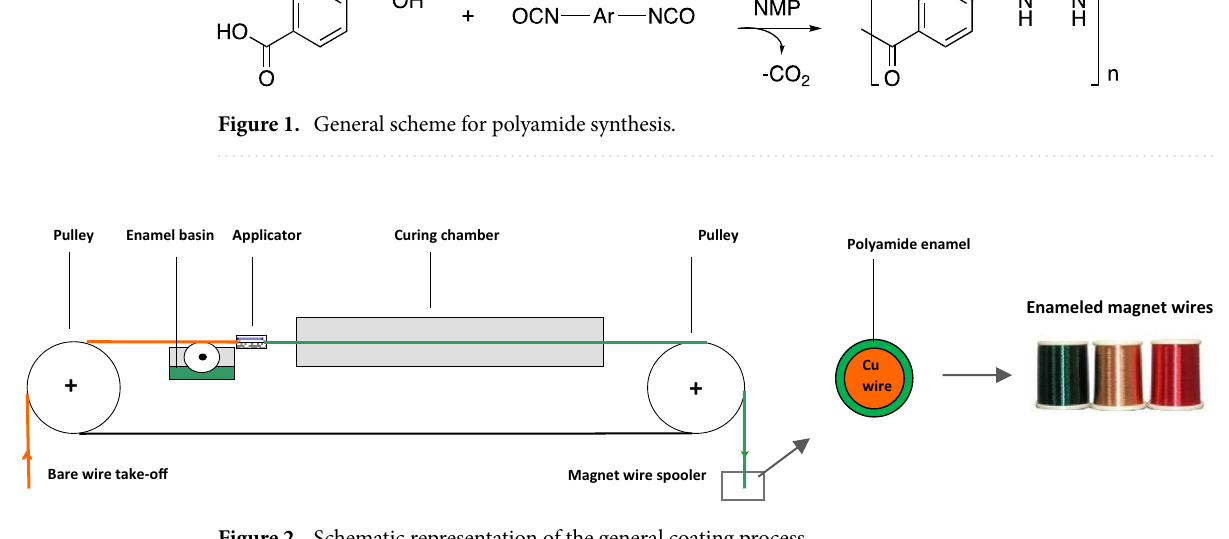
Figure 2. Schematic representation of the general coating